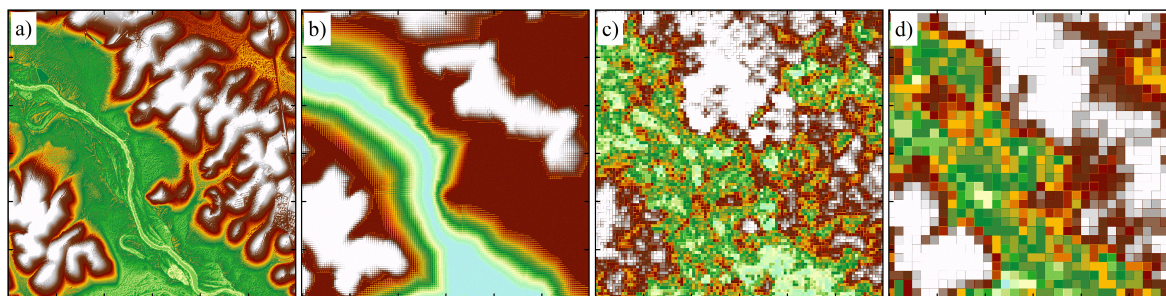
Figure 2. Original DEMs used in this study, based on (a) lidar data, (b) contour map, (c) ASTER data and (d) SRTM data.